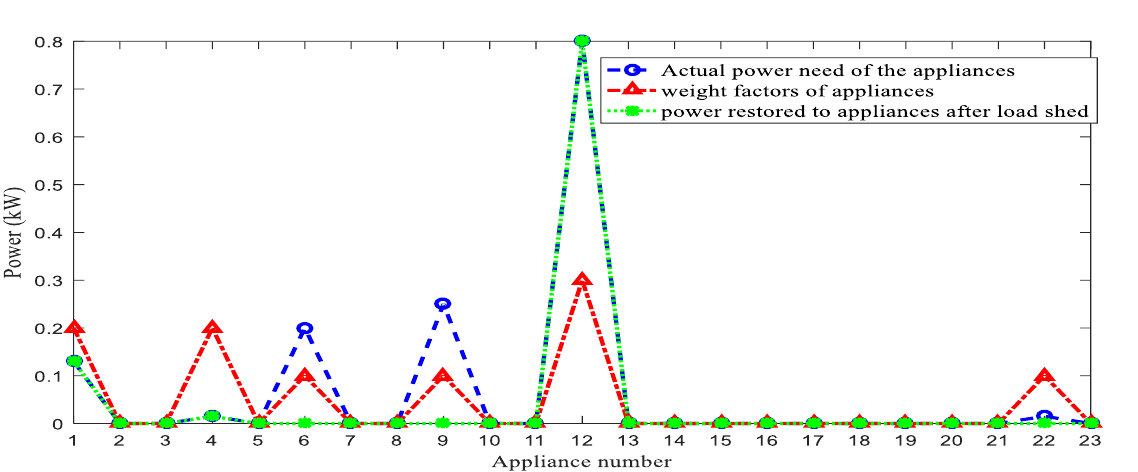
Figure 10. Actual load to meet, weight factors assigned for priority of appliance, and power restored due to EVs for residential user 4.